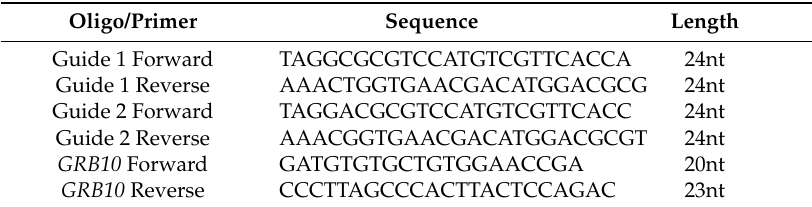
Table 3. Guide Oligos and Genotyping Primers used in the